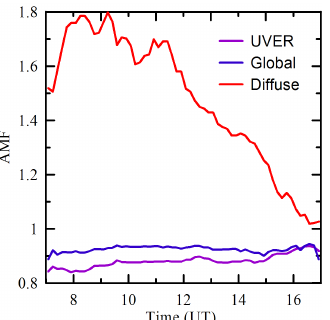
Figure 4. Daily evolution Aerosol Amplification Factors, AMF UVER (purple) AMF G (blue) and AMF D (red), on 26 August 2012 at Marsaxlokk,